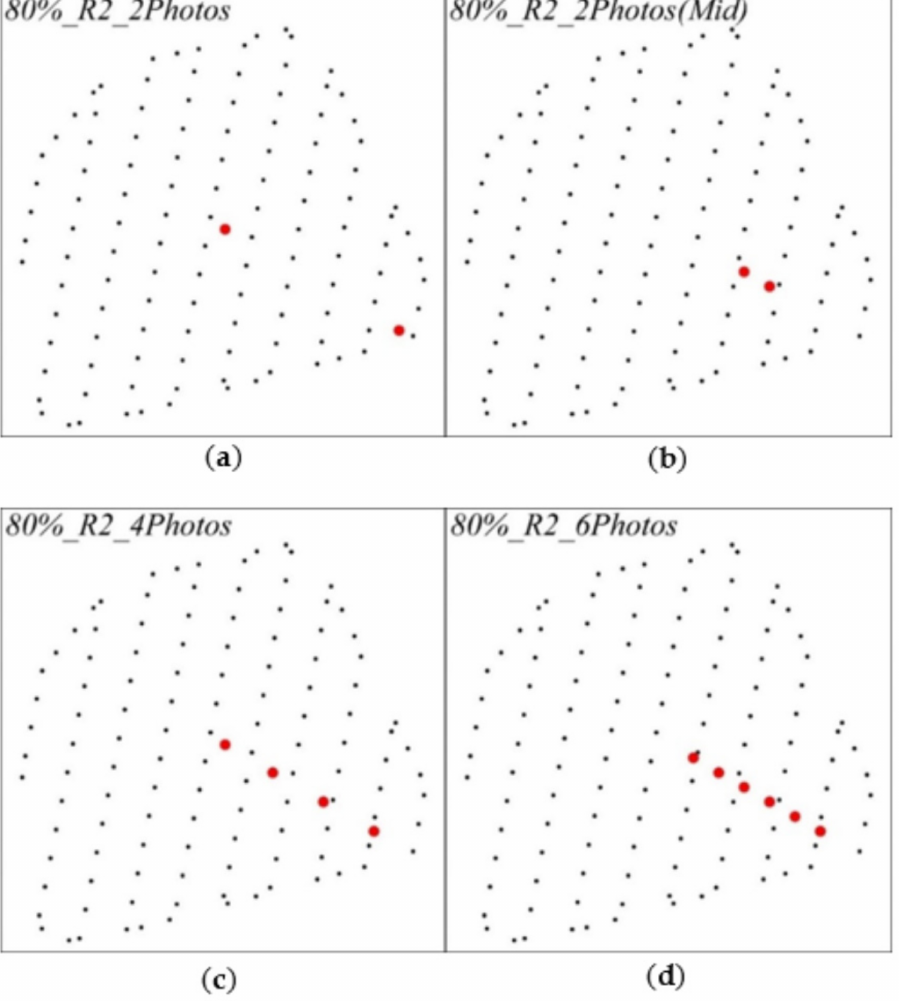
Figure 5. 4 different oblique imaging numbers and location schemes, ( a ) 2 images in the end of the oblique flight route, ( b ) 2 images in the middle of the oblique flight route, ( c ) 4 images at equal intervals of the oblique flight route, ( d ) 6 consecutive images in the middle of the oblique flight route. (Black points are orthophoto waypoints, red points are oblique imaging